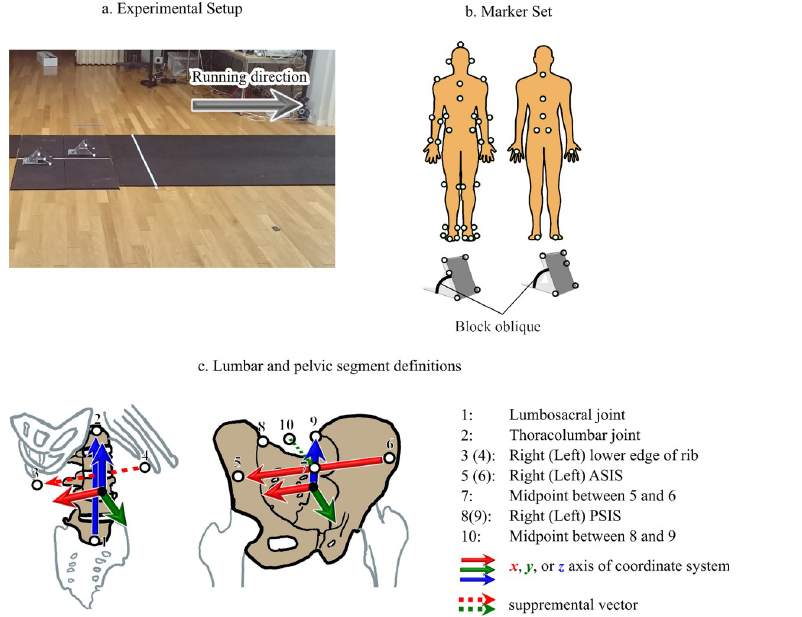
Fig 1. Experimental setup (a), marker setup (b), and definitions of lumbar and pelvic segments